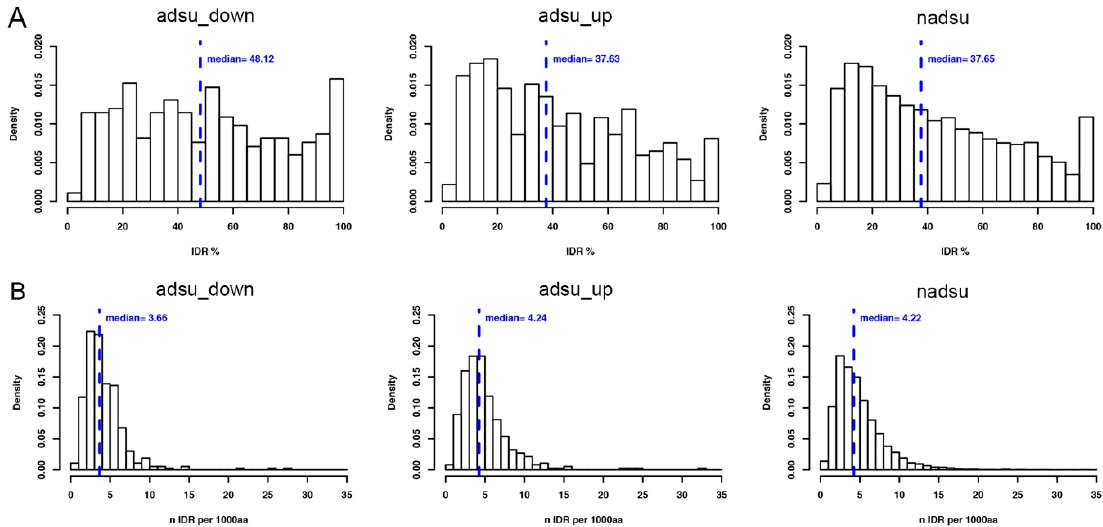
Figure 2. Relative frequency distributions of proportion of IDR per protein and length-normalized number of IDRs per protein for proteins encoded by adsu_down genes in relation to adsu_up and nadsu genes. IDR predictions were made using VSL2b. ( A ) Relative frequency distributions (Density) of IDR-containing proteins with different percent IDR content. The median position and value are shown in blue. ( B ) Relative frequency distributions (Density) of numbers of IDRs per IDR-containing protein, normalized for differences in protein length (IDR number per 1000 amino acid residues). The median position and value are shown in blue.